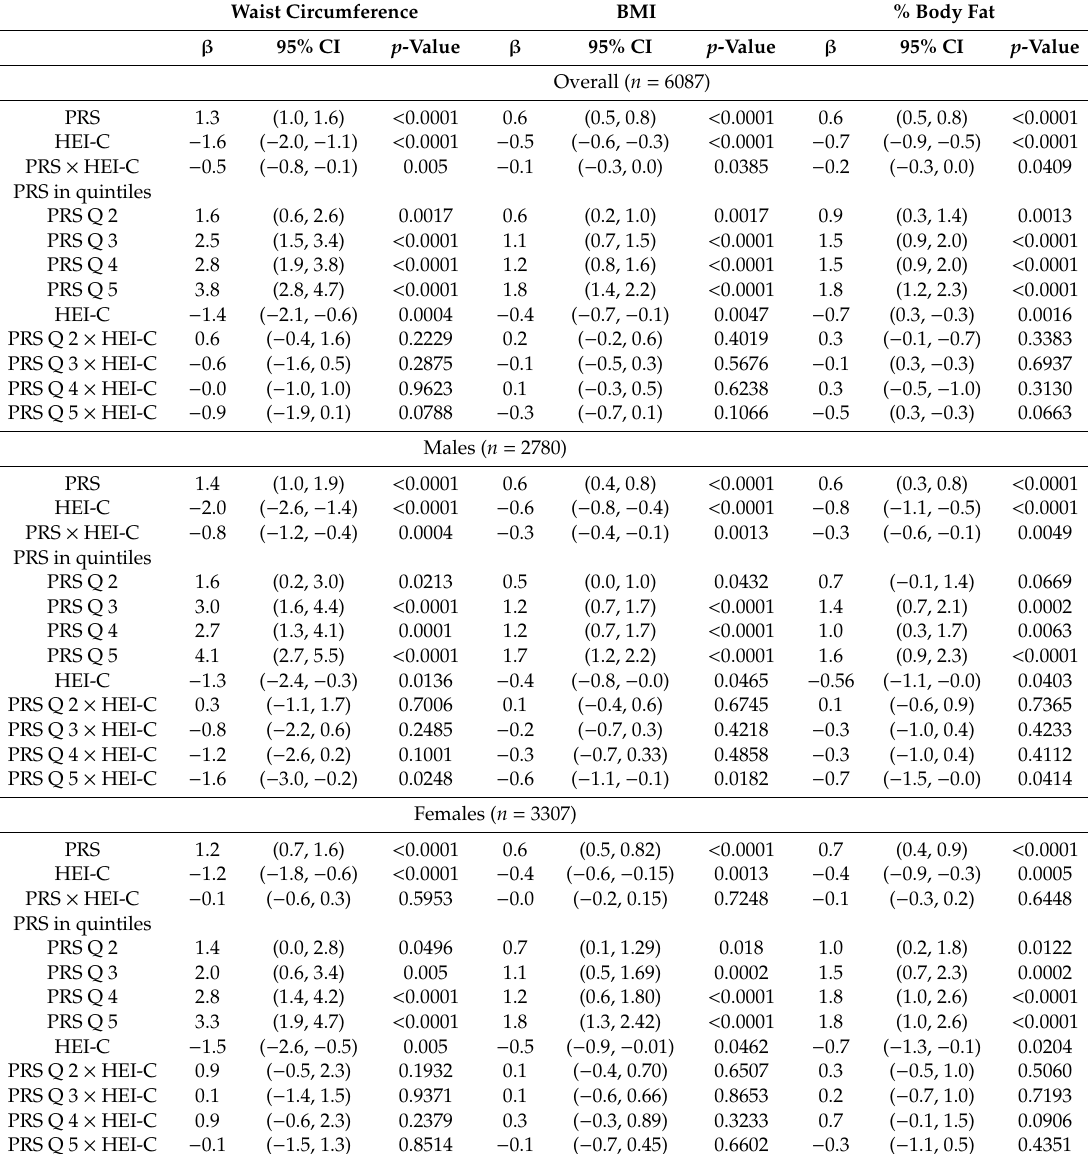
Table 5. PRS and HEI-C main and interaction e ff ects on adiposity-related outcomes, overall and by sex, among diet